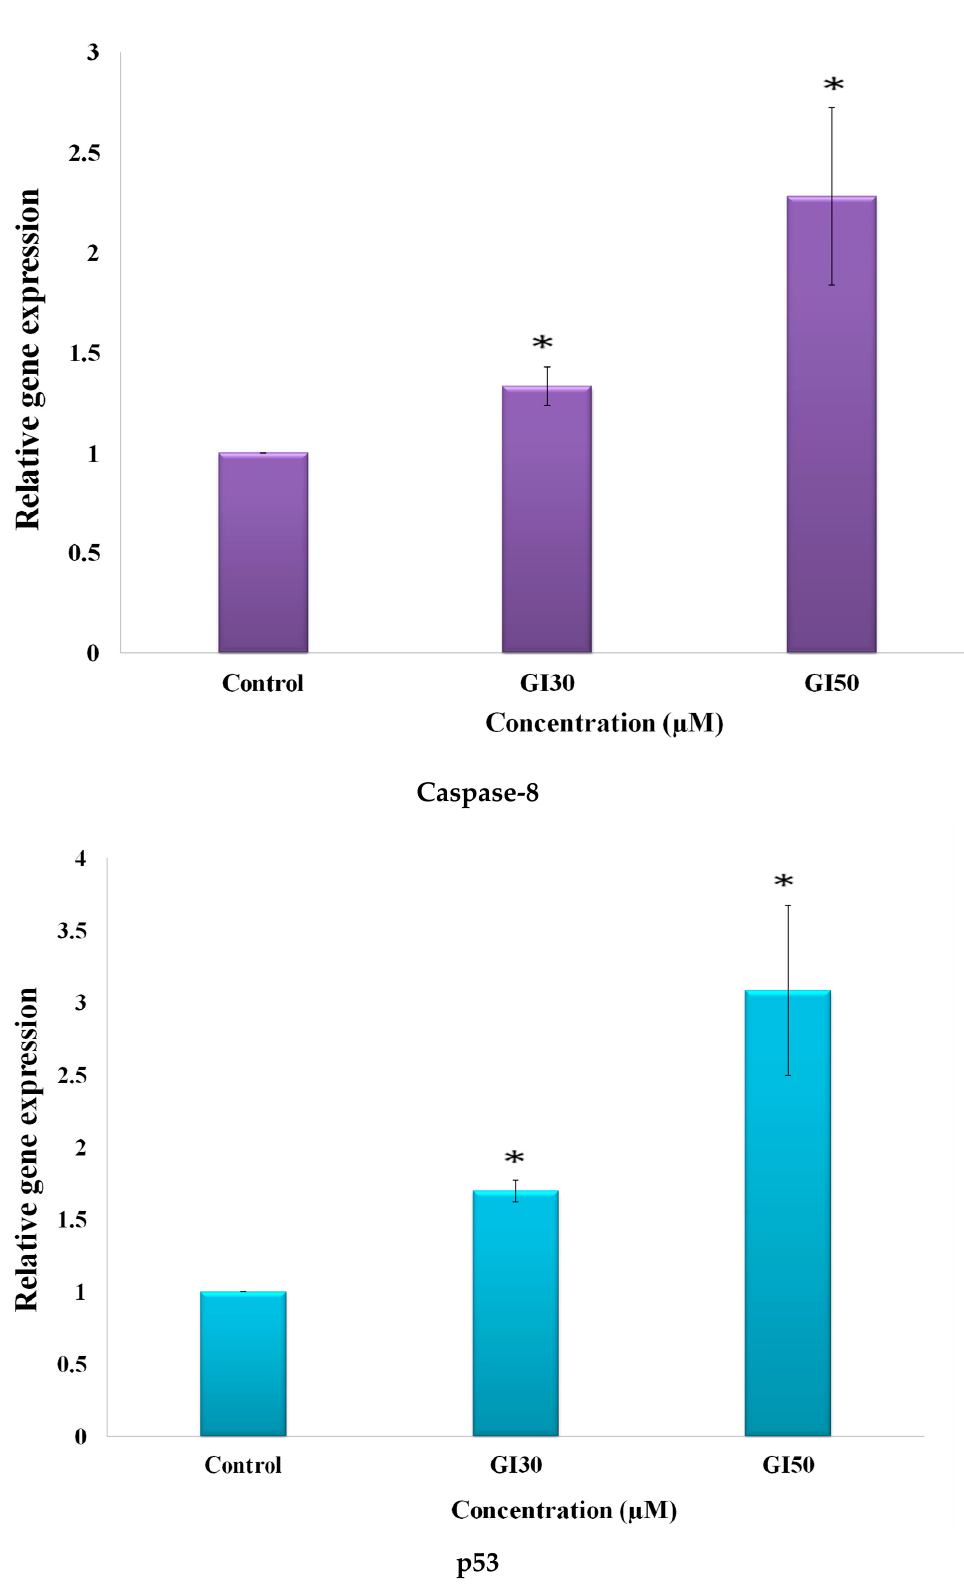
Figure 17. E ff ect of Epiafzelechin from C. fistula on the gene expression for CDK2 (cyclin-dependent kinases-2), β -catenin, caspase-8, and p53 genes in MG-63 cells as detected using RT-PCR. Values are expressed as mean ± SE. * indicates statistically significant di ff erence at ( p ≤